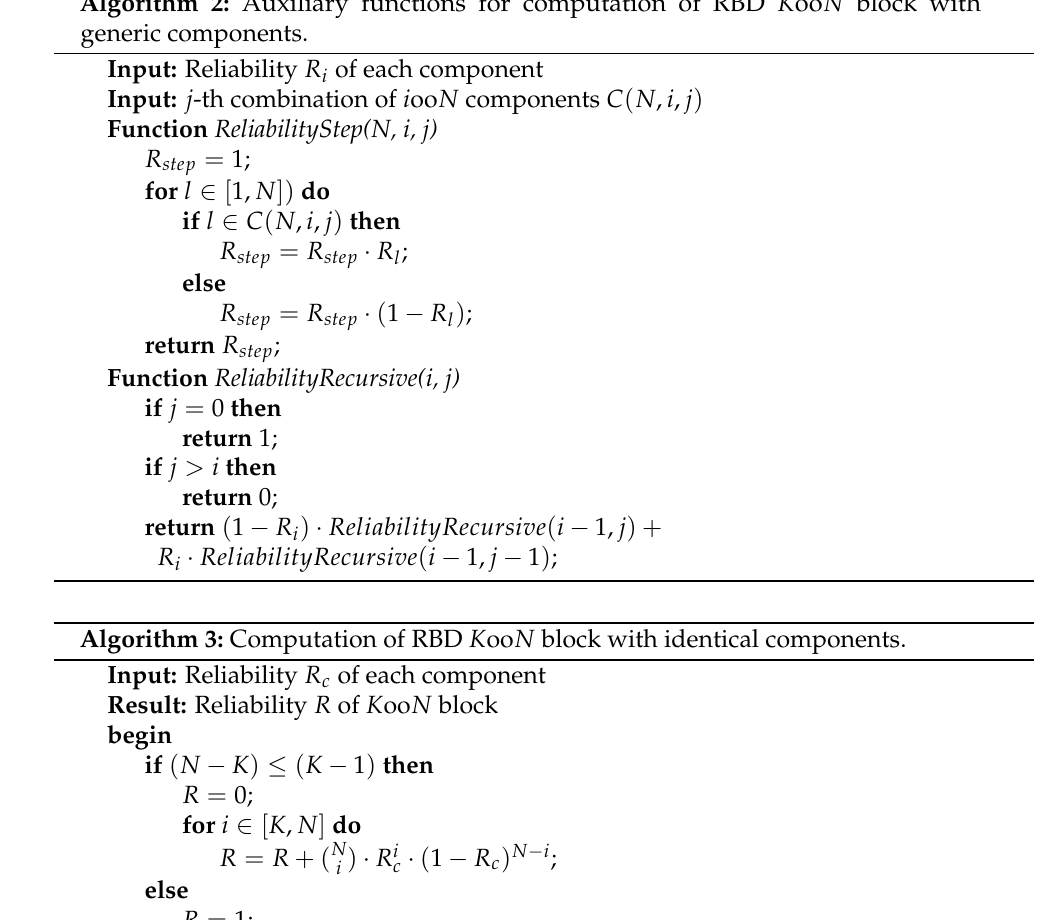
Algorithm 2: Auxiliary functions for computation of RBD K oo N block with